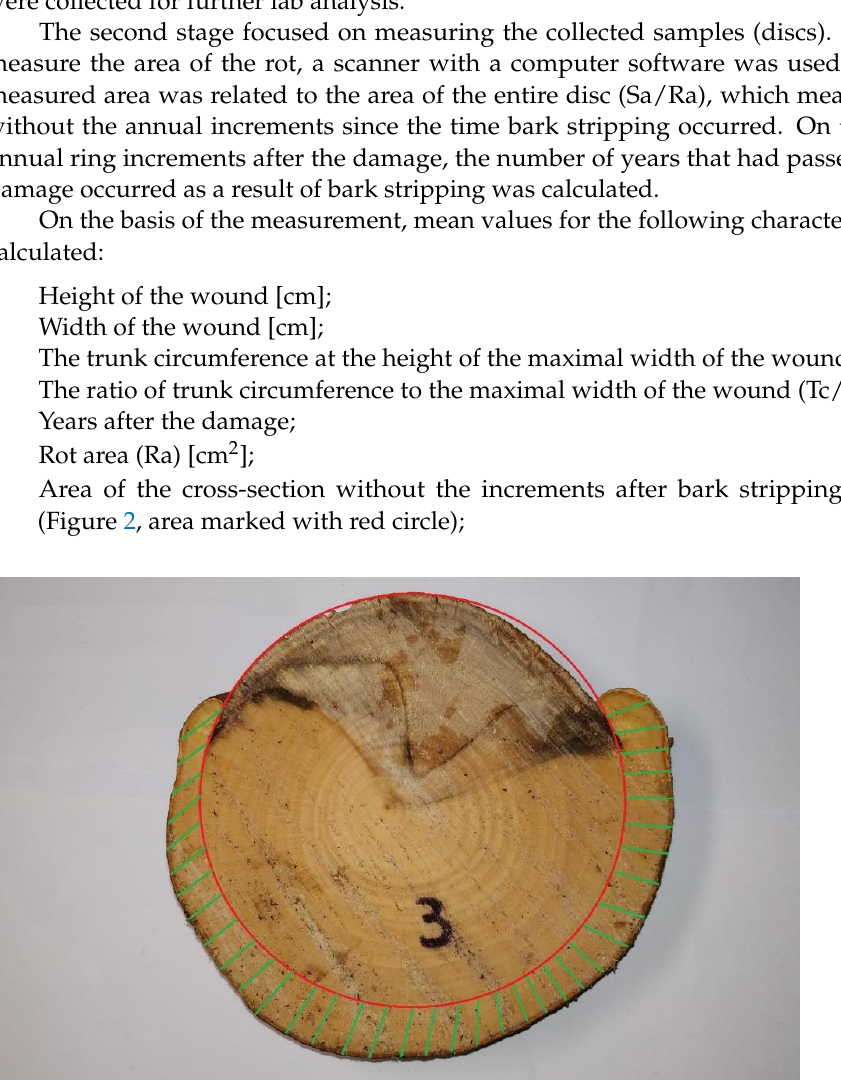
Figure 2. A cross-section collected from within the wound (red colour marks the area to the moment the damage occurred, green marks the annual rings which grew after bark stripping) (photo K. Lewandowski).